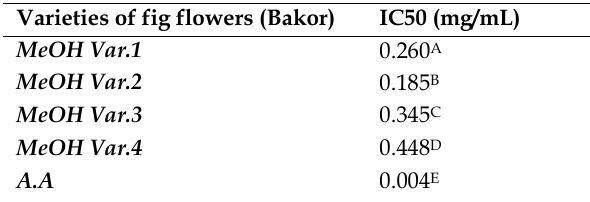
Figure 5 . % inhibition of DPPH. MeOH Var.1; MeOH Var.2: Variety 1, 2 Bakor (Fig flowers) of Bechar. MeOH Var.3; MeOH Var.4: Variety 3, 4 Bakor of Mascara Compared to the positive control IC50 value 0.004 mg/g DW, the lowest IC50 equal to 0.185 mg/g DW was deduced for methanolic extract of Bechar ( MeOH Var.2 ), which chelated 87.9± 1.23 % of the DPPH free radical. However, the extract MeOH Var.4 has presented the lowest %IP of 63.5 ± 0.87% with an IC50 value of 0.448 mg/g DW. Our results showed a statistically significant difference between studied extracts and positive controls ( p < 0.05 ). Table 1. IC50 value of fig flowers fruits methanolic